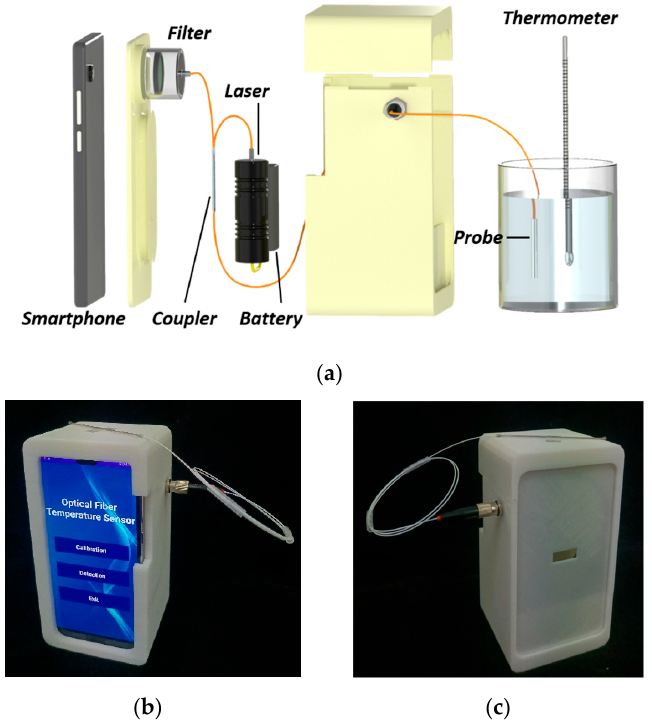
Figure 2. Optical fiber fluorescence temperature sensor. ( a ) Design sketch of the sensor; ( b ) front view photo of sensor; ( c ) back view photo of sensor.